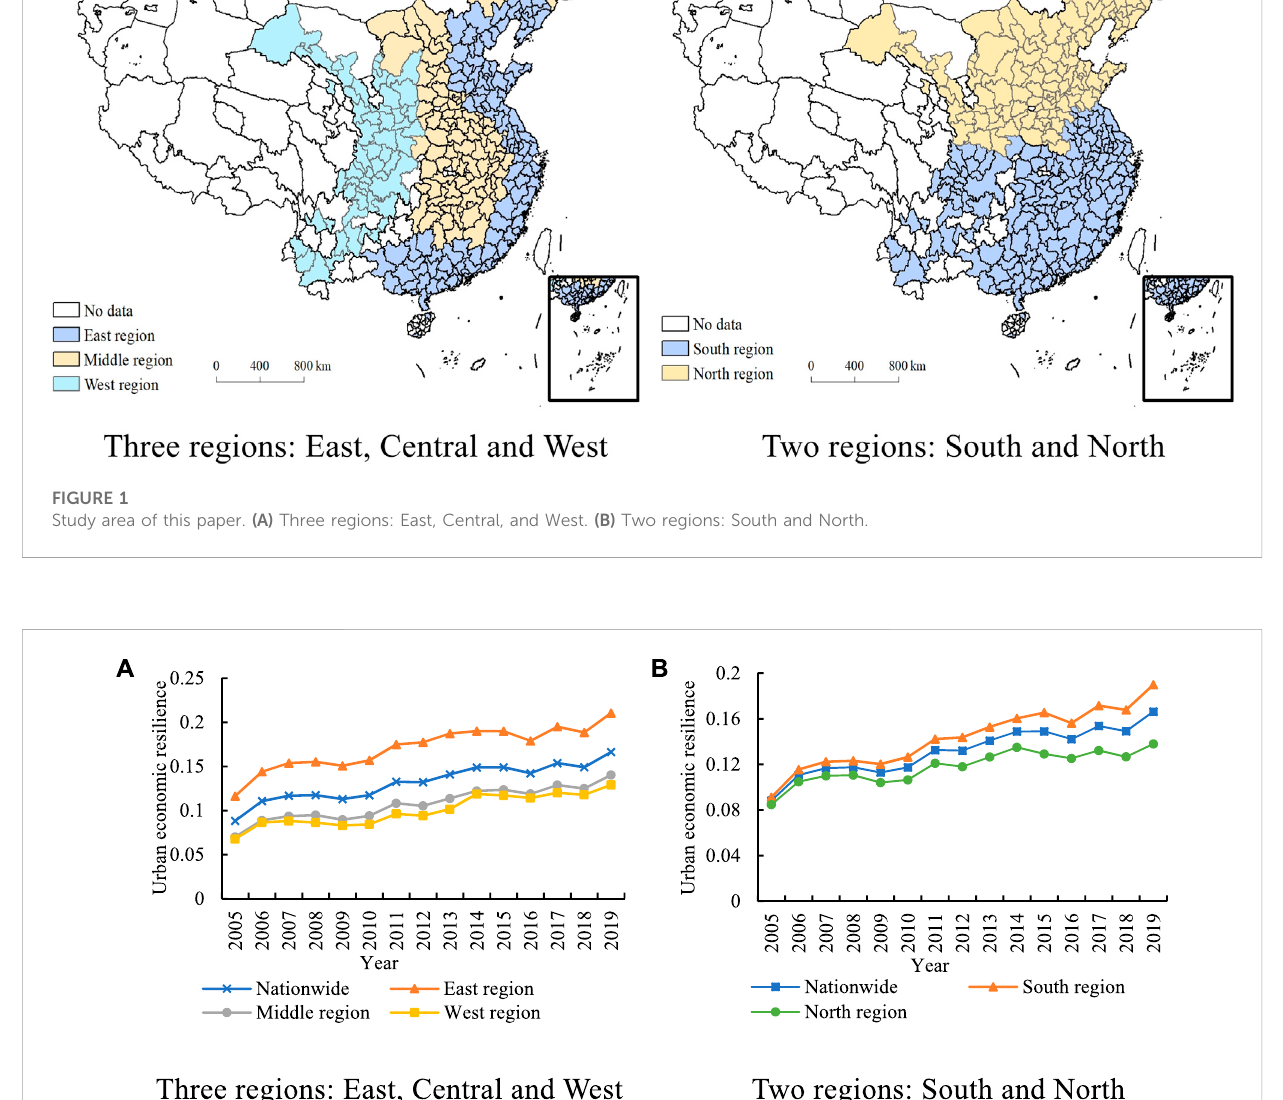
FIGURE 2 Temporal distribution characteristics of economic resilience. (A) Three regions: East, Central, and West. (B) Two regions: South and